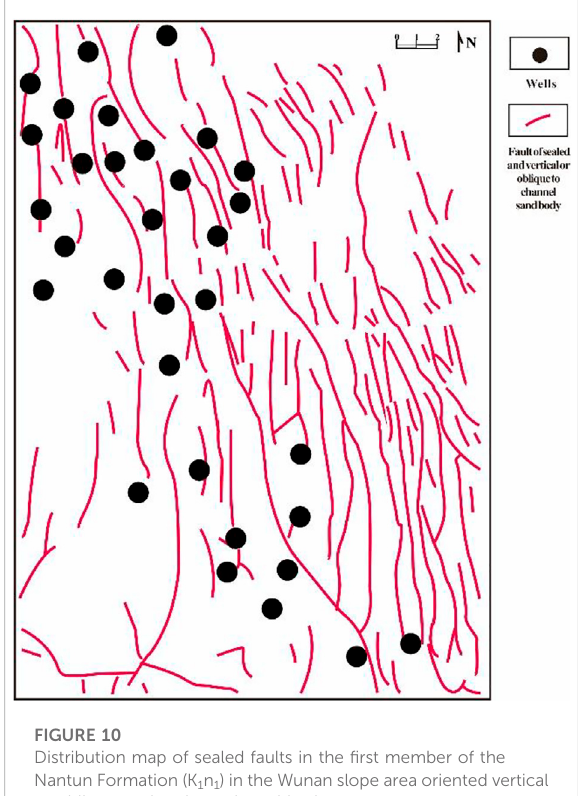
FIGURE 10 Distribution map of sealed faults in the fi rst member of the Nantun Formation (K 1 n 1 ) in the Wunan slope area oriented vertical or oblique to the channel sand